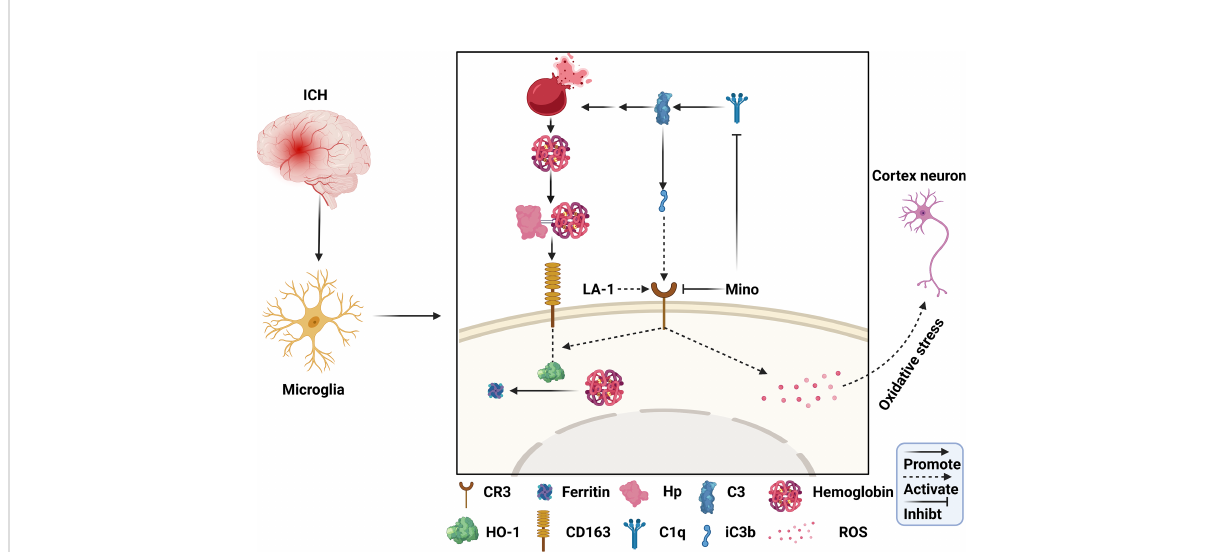
FIGURE 10 Schematic mechanism of CR3 regulates brain damage and hematoma resolution after ICH and the effect of minocycline treatment. The ICH insult activates the complement cascade. CR3 activation can exacerbate brain injury after ICH by promoting oxidative stress in perihematomal microglia and cortical neurons. Complement-mediated erythrolysis results in the release of hemoglobin, and CR3 activation upregulates the CD163-OH-1 pathway to accelerate hematoma clearance. Minocycline inhibits C1q and CR3, and alleviates brain damage via repressing CR3- induced oxidative stress and hematoma